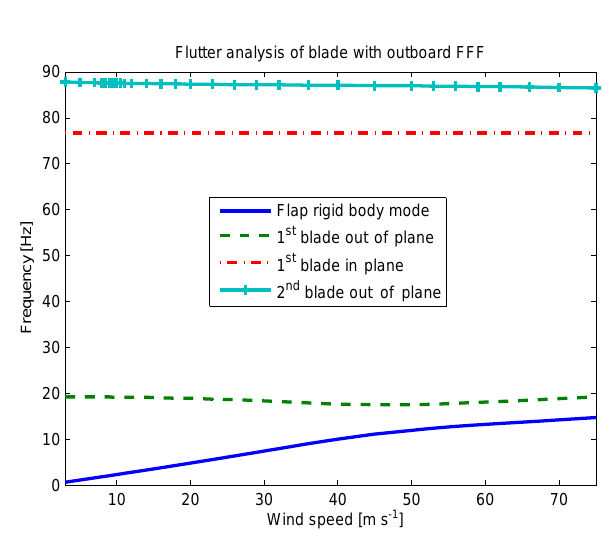
Figure 8. Variation in modal frequency with total incident air speed.